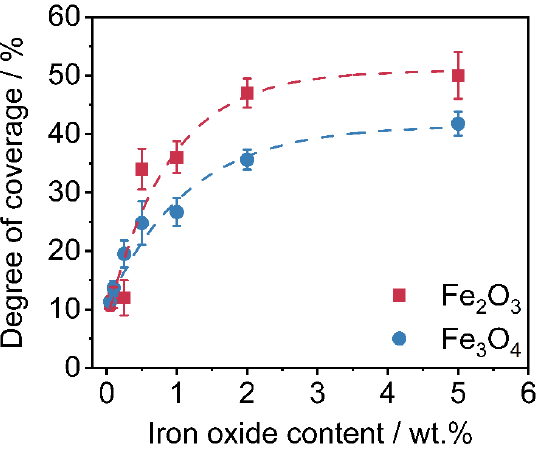
Figure 5. Degrees of coverage of the nanoparticles on the polymer surface ( n = 3).